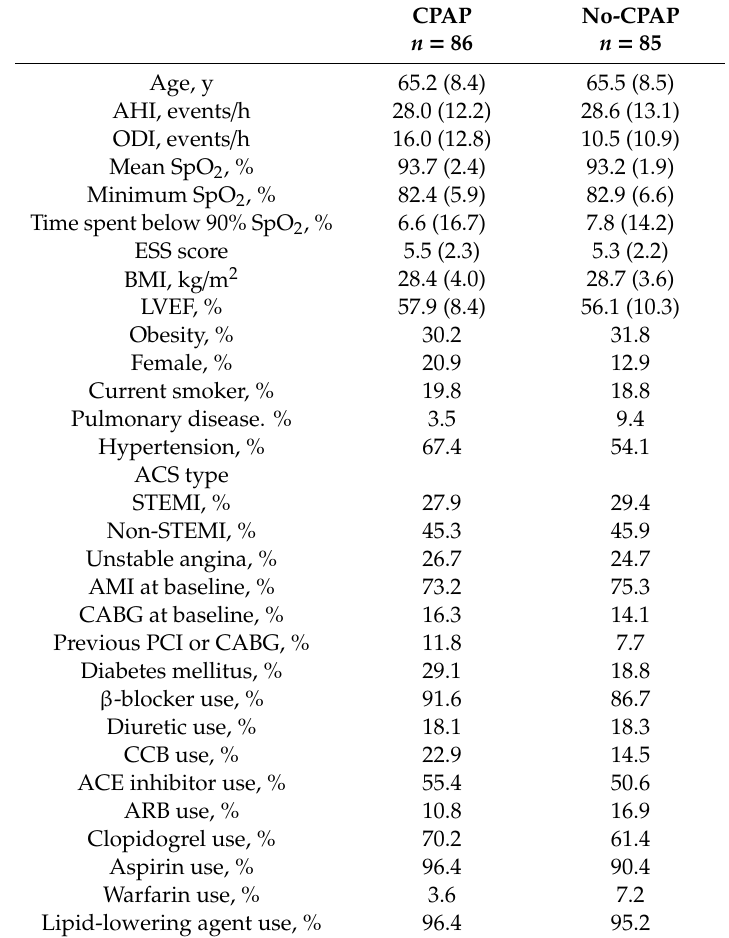
Table 1. Demographic and clinical characteristics of the ACS patients with non-sleepy OSA randomized to CPAP versus no-CPAP at baseline